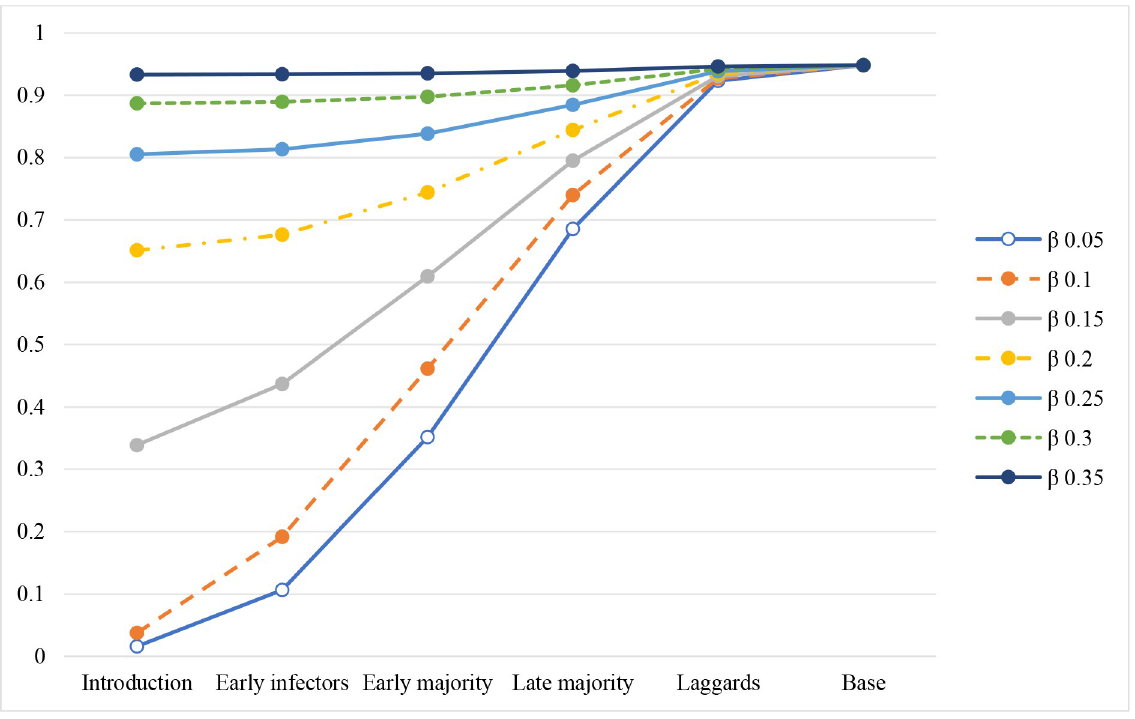
Fig 5. The cumulative infected (i.e., the recovered fractions or total infected) with different countermeasures on transmission rates ( β beta).